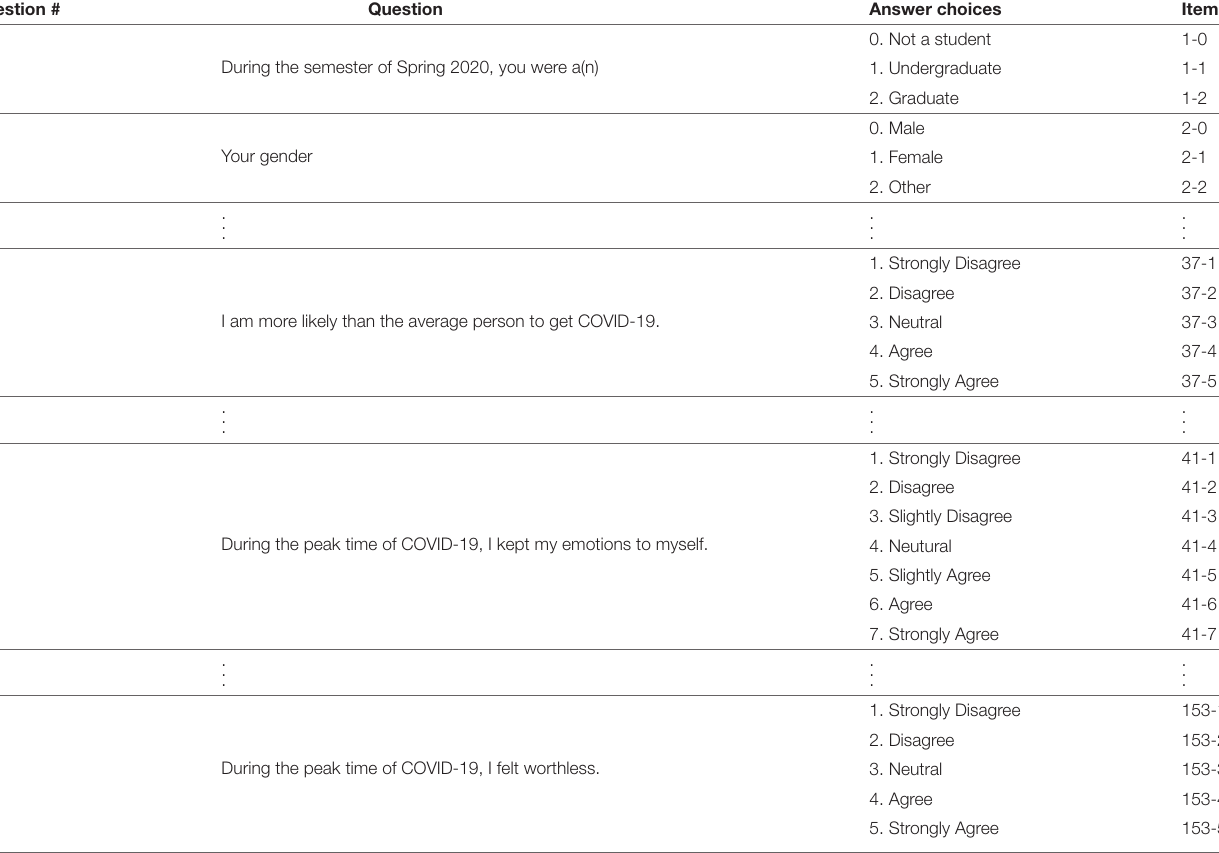
TABLE 3 | Survey question-answer encoding.